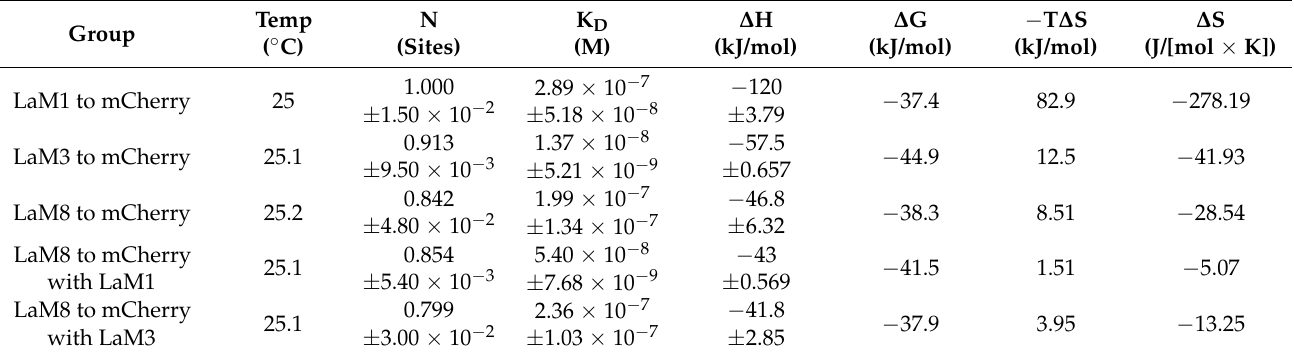
Table 3. The binding parameters and relative thermodynamic parameters between LaM nanobodies to mCherry or mCherry-LaM complex by isothermal titration calorimetry.